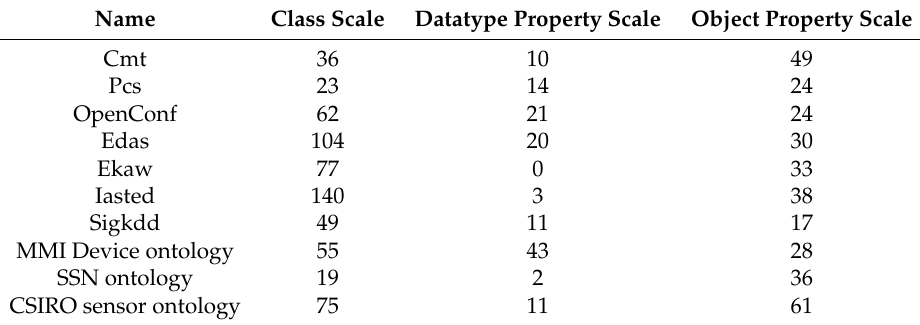
Table 1. A brief description on the sensor